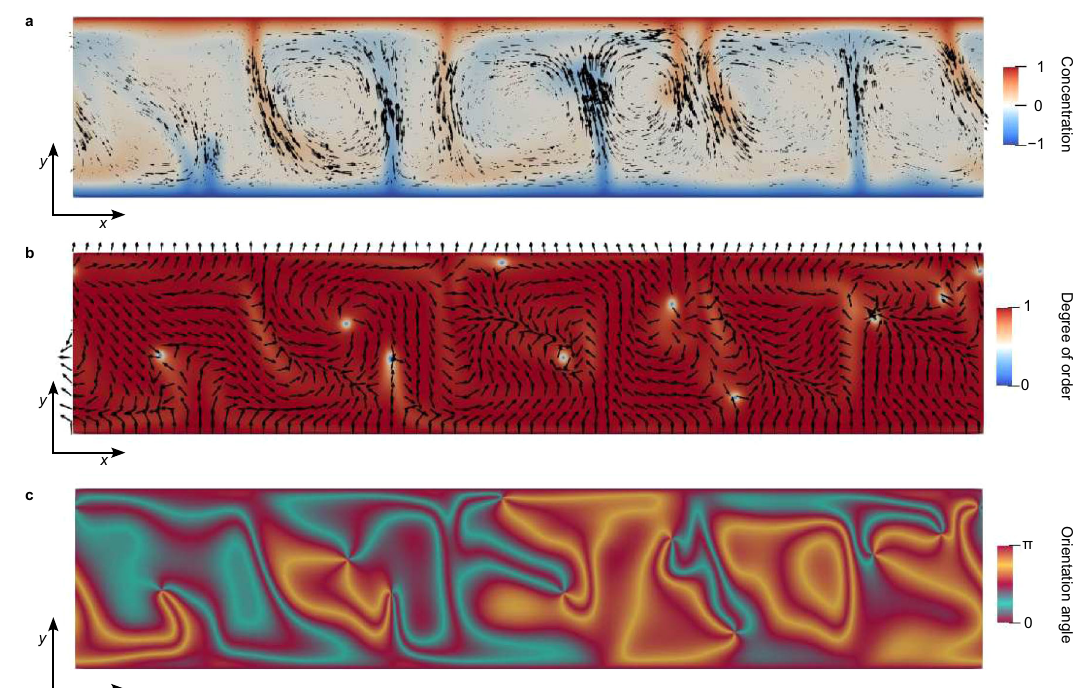
Fig. 7 | Dynamic nematic regime at strong fl ow driving (high Ra number). a Chaotic fl ow fi eld (black arrows) emerges with irregular structures of fl ow vor- tices. The colormap shows the corresponding concentration fi eld of the photo- initiator. b Topological defects emerge in the nematic orientational fi eld, as seen both in the vectorial orientational nematic fi eld (black arrows) and in the nematic